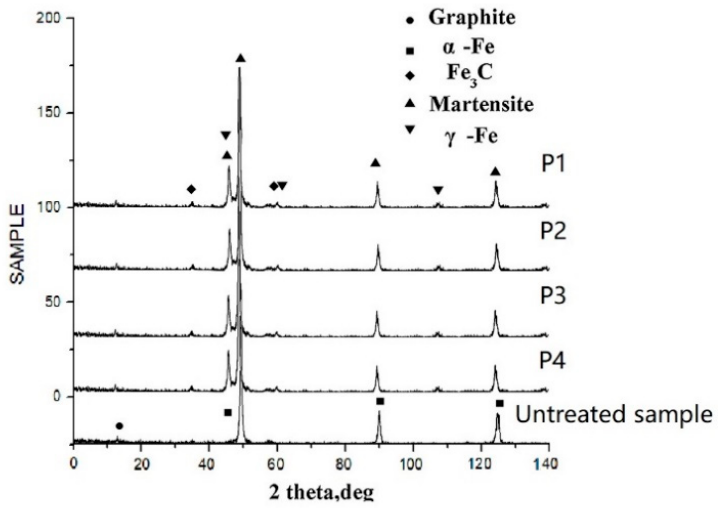
Figure 9. X-ray di ff raction analysis of elements with di ff erent Figure 9. X-ray diffraction analysis of elements with different distribution.